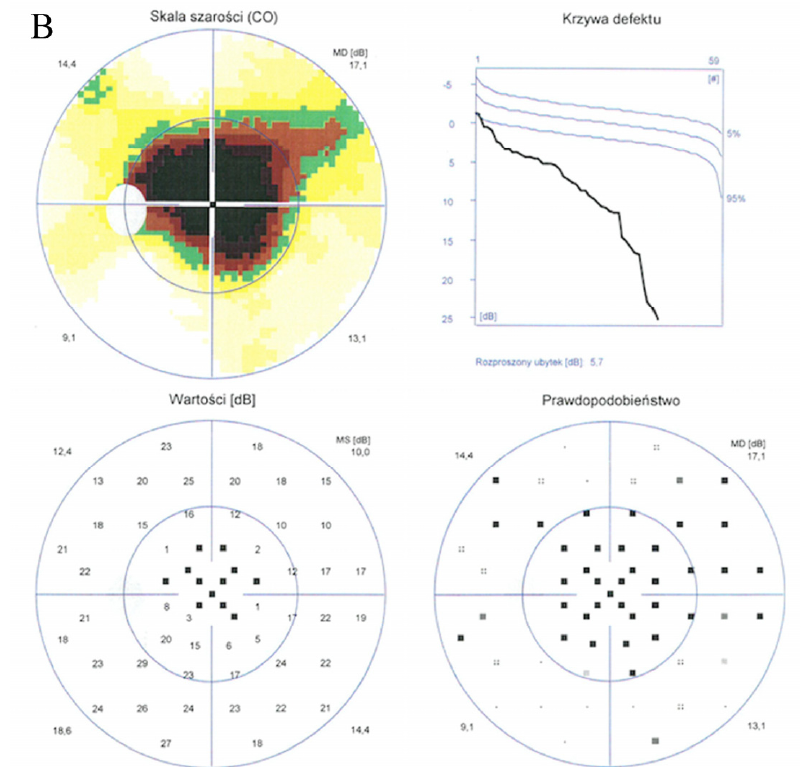
Figure 3. Static perimetry showed a central scotoma with saving peripheral vision in both eyes. The right eye ( A ) MS (mean sensitivity): 13.7 dB; MD (mean deviation): 13.6; sLV (standard loss variance): 9.8. The left eye ( B ) MS: 13.6 dB; MD: 13.8; sLV: 10,8.